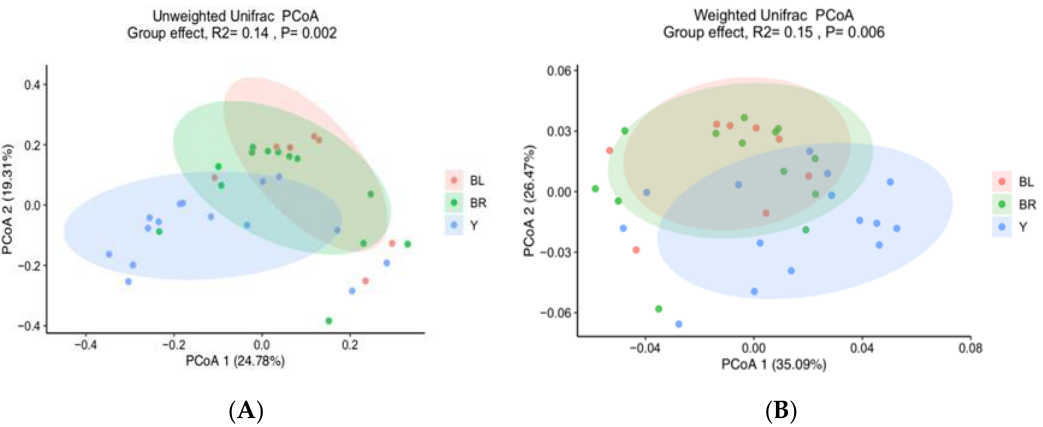
Figure 5. PCoA plot based on weighted ( A ) and unweighted ( B ) Unifrac matrices. Each dot represents the GM community of one sample grouped according to colon content color—yellow, brown, and black.